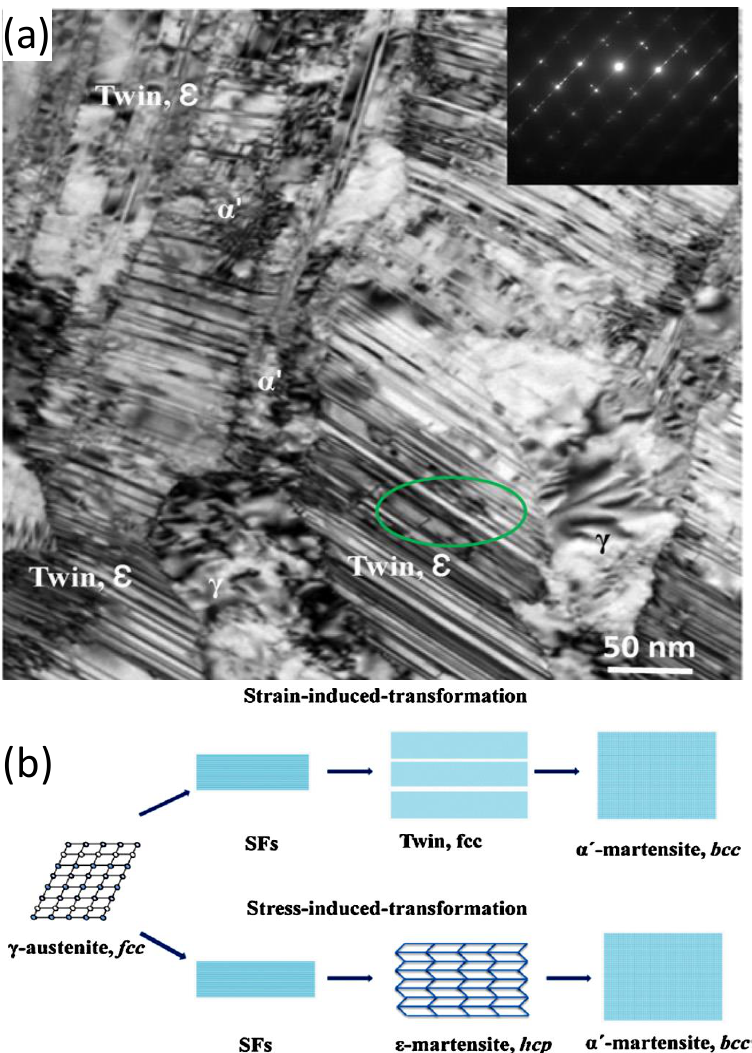
Figure 3. (a) TEM micrograph and ( b ) schematic diagram, depicting how the FCC γ phase transforms to the BCC α’ phase via planar shear creating stacking faults followed by bulk shear of twins and/or ε-martensite as intermediary stages. Modified from [6].